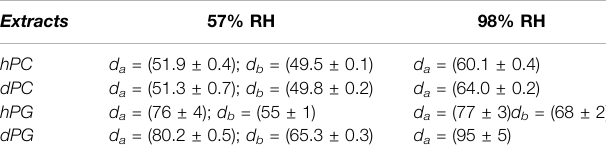
TABLE 2 | d -spacing values calculated for the hPC, dPC and hPG, dPG multilayers at 57% and 98% RH.